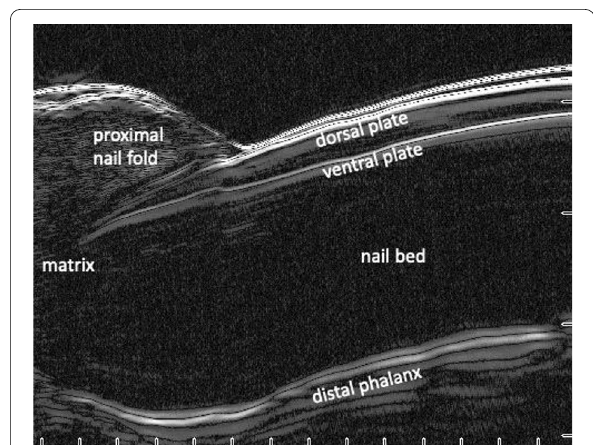
Fig. 3 Longitudinal view of a normal nail using a 50-MHz HFUS probe (Longport, Inc. EPISCAN). Note the bilaminar appearance of the nail plate consisting of the hyperechoic dorsal and ventral nail plates separated by a hypoechoic band. The top-most hyperechoic horizontal line represents the probe